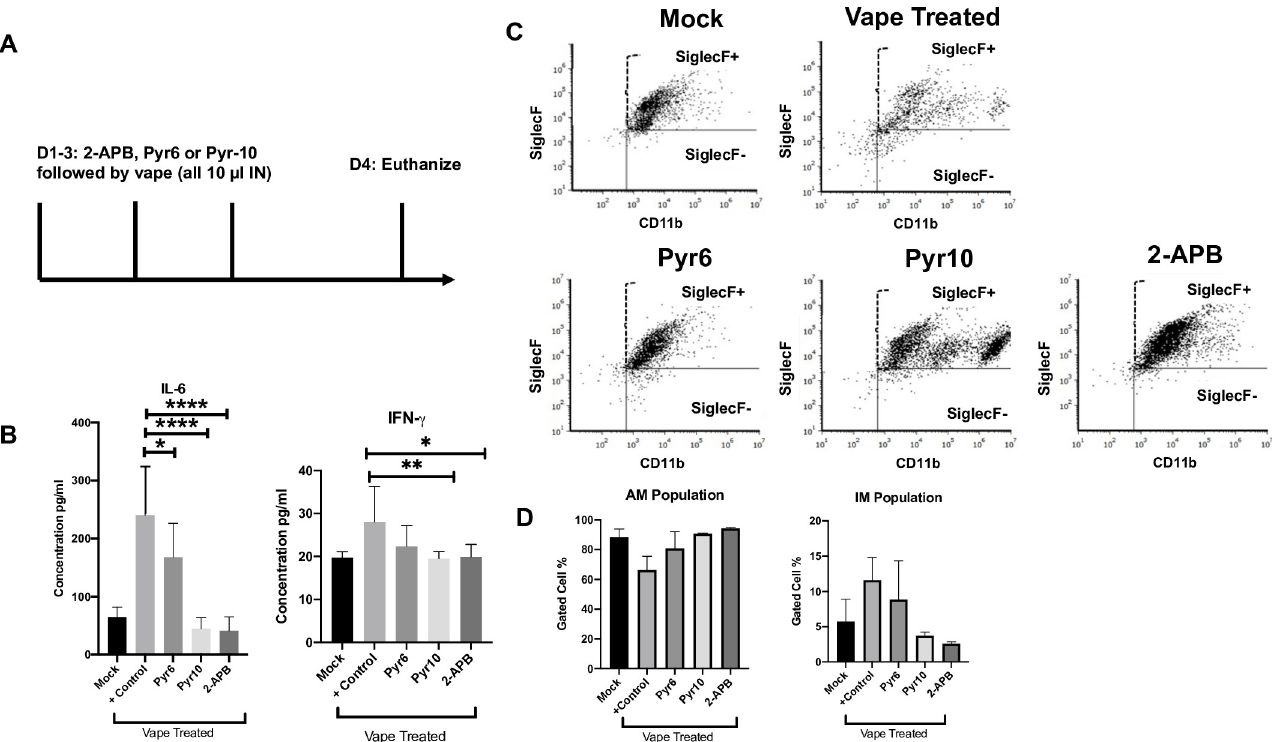
Fig 2. Increased intracellular Ca 2+ levels mediate vape-induced inflammation. (A) Study design. Mice were simultaneously vaped and treated with the Ca 2+ channel antagonists Pyr6, Pyr10 or 2-APB for 3 days. n = 6 mice per treatment group. After being euthanized, BAL fluid was collected, and (B) a Luminex cytokine panel including IL-6 and IFN- γ was run using the clarified BAL fluid. (C) Cells collected after clarifying the BAL fluid were then analyzed using flow analysis and (D) tabulated. n = 2–3 flow analyses per group with a representative image (C) for each group shown. IM = SiglecF-/CD11b+ and AM = SiglecF +/CD11b+. Symbols and bars represent the mean ± SEM compared to mock control ( � P < 0.05, �� P < 0.01, ���� P < 0.0001). AM = alveolar macrophage, IM = interstitial macrophage.